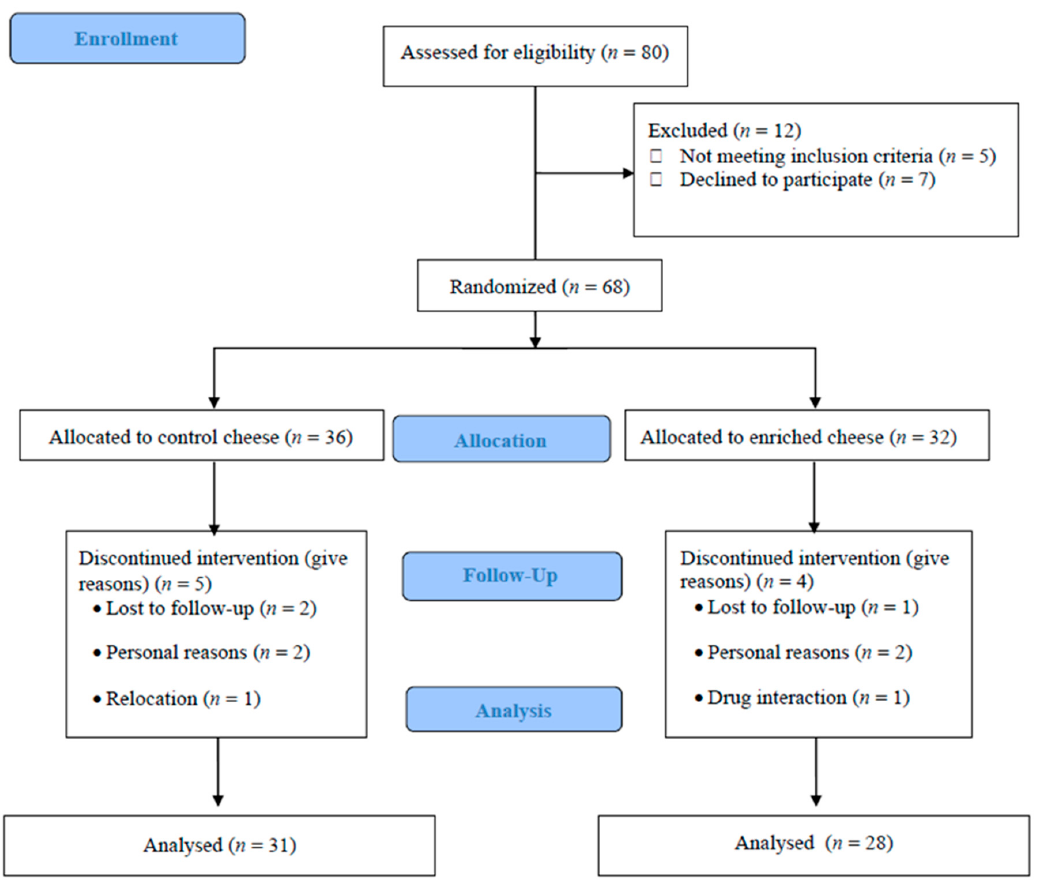
Figure 1. Flow chart describing the present trial.